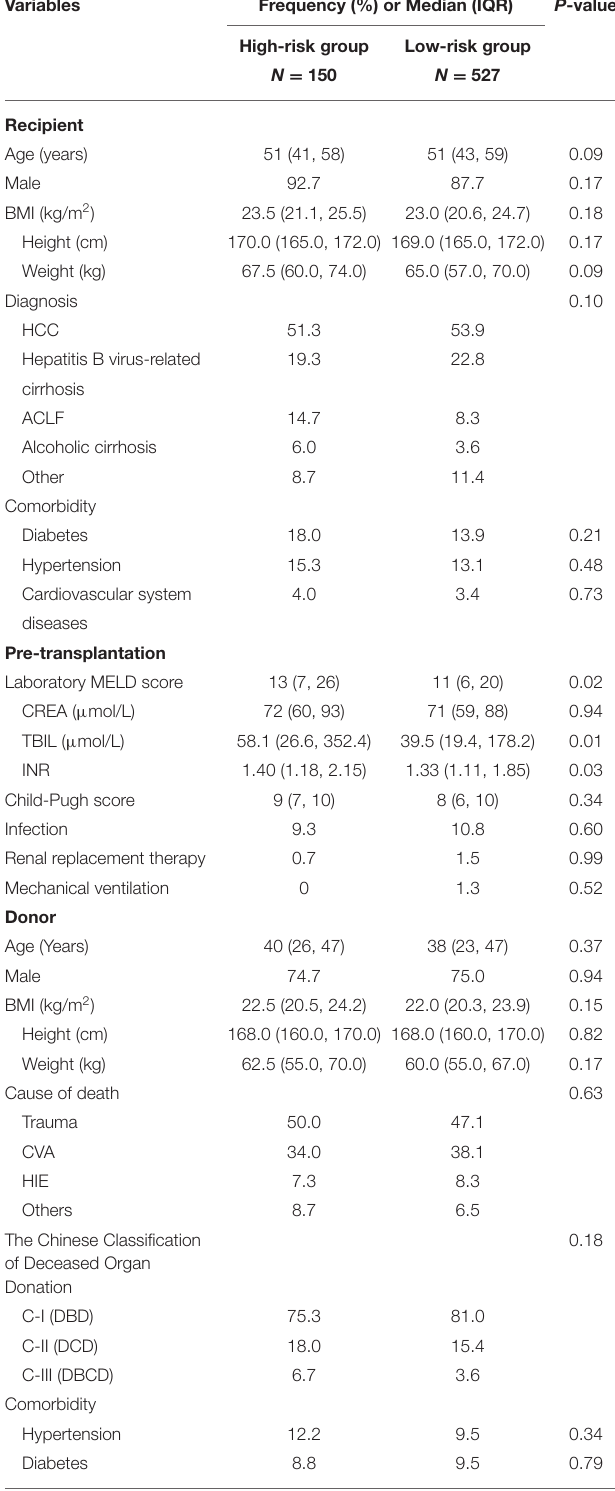
TABLE 2 | Univariable analysis of characteristics between L-GrAFT 7 high and low risk group.